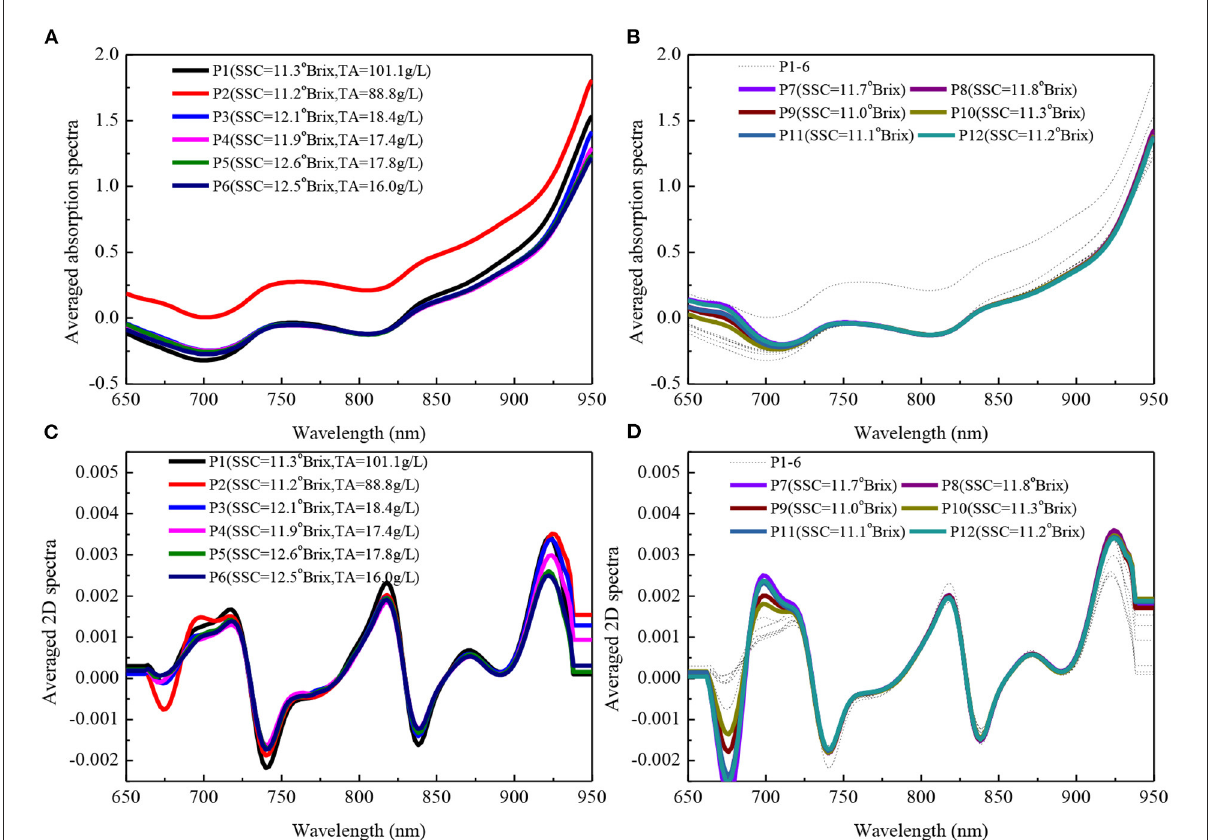
FIGURE3 Averaged absorption (A,B) and 2D (C,D) spectra for 12 populations. For better comparison with P7–12, P1–6 was represented with a thin, black and dashed line in panel (B,D) . P represented population.